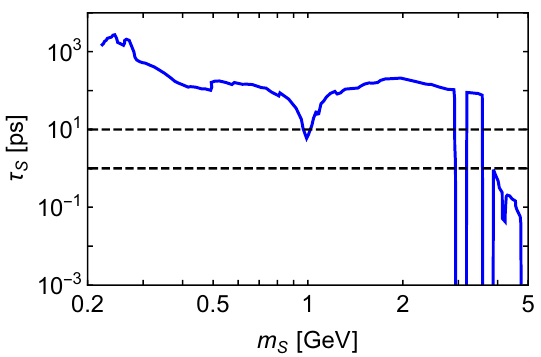
Figure 7 . Lifetime of the scalar particle S as a function of its mass, thereby (cid:12)xing sin (cid:18) to the lower bound of the current LHCb sensitivity as shown in (cid:12)gure 3 (blue line). The black dashed lines correspond to lifetimes of 1 ps and 10 ps, thus indicating the borders between the prompt region ( (cid:28) S < 1 ps), the intermediate region (1 ps < (cid:28) S < 10 ps) and the large displacement region ( (cid:28) S > 10 ps). See text for further